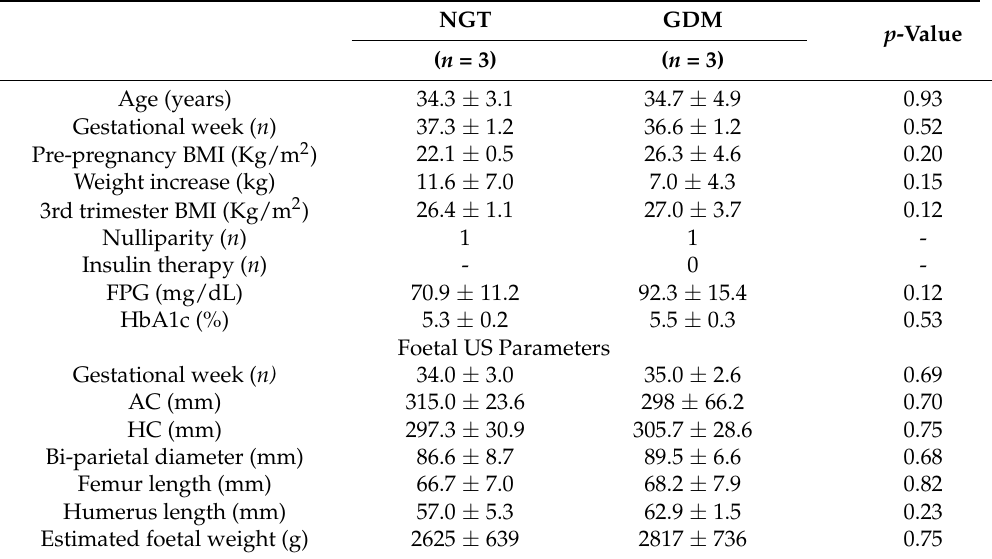
Table 1. Clinical and biochemical parameters of the discovery cohort.